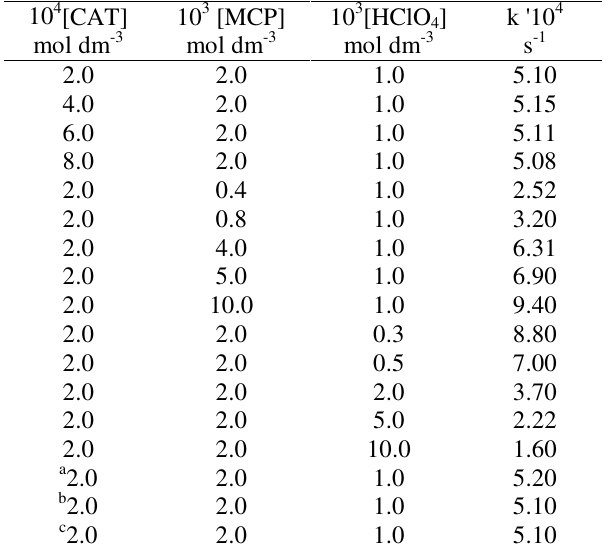
Table 1. Effect of varying concentrations of oxidant, substrate and acid on the reaction rate constant